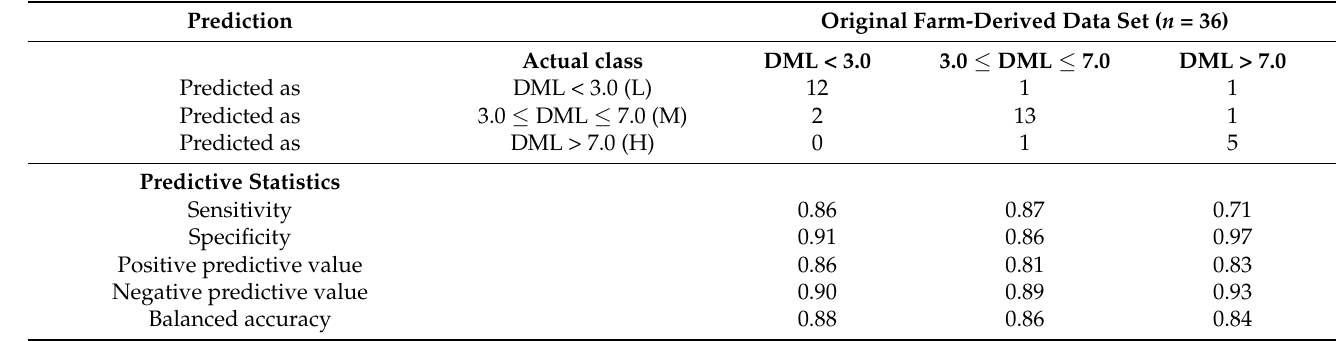
Table 2. The confusion matrix for the decision tree model applied to three dry matter losses (DML as %) quantitative classes (low, L vs. medium, M vs. high,